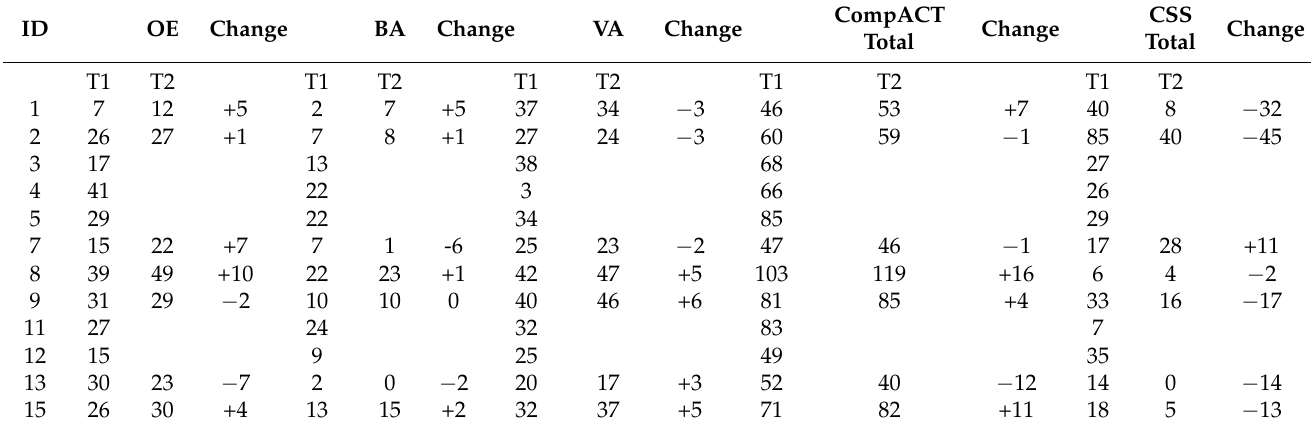
Table 13. CompACT-measured PF and CSS COVID stress pre- and